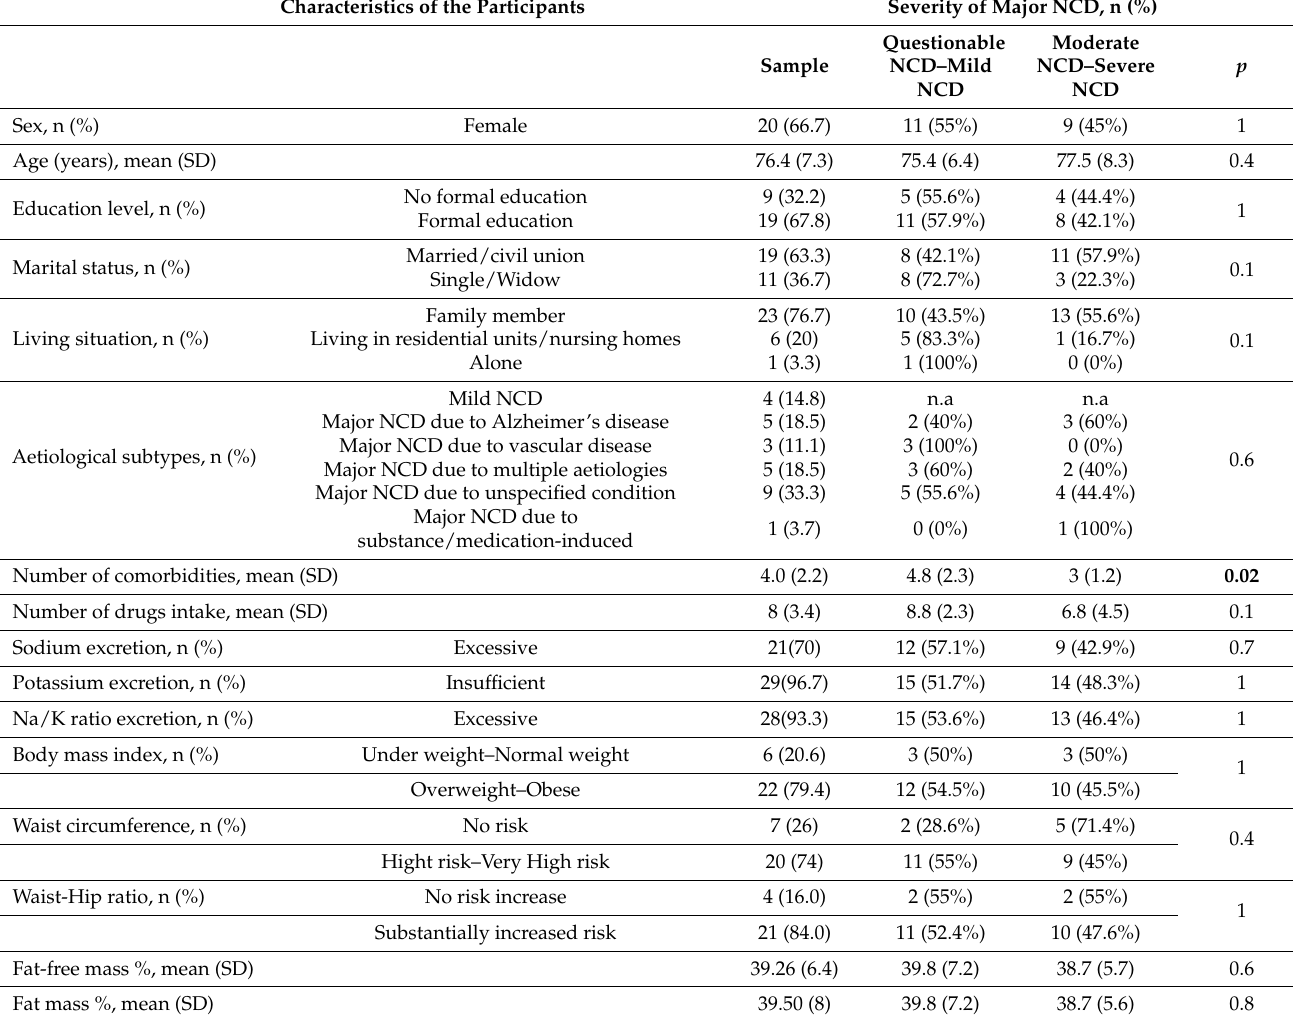
Table A1. Characteristics of the participants according to the severity of major